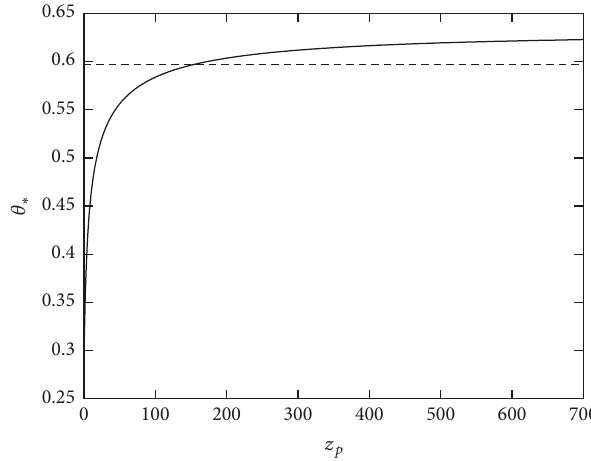
= 0.26 , Ω = 0.04 , Figure 5: Function 𝜃 ∗ (𝑧 𝑝 ) for Ω Λ = 0.7 , Ω 𝑏,0 DM ,0 Ω = 4.6 × 10 −5 , and 𝐻 = 73.24 km s −1 Mpc −1 for the high- 𝛾,0 0 𝑧 SU (2) and low- 𝑧 Λ CDM interpolating cosmological model CMB considered. Also indicated is the value 𝜃 ∗ = 0.597 ∘ (dashed line), fitted to the CMB TT power spectrum.